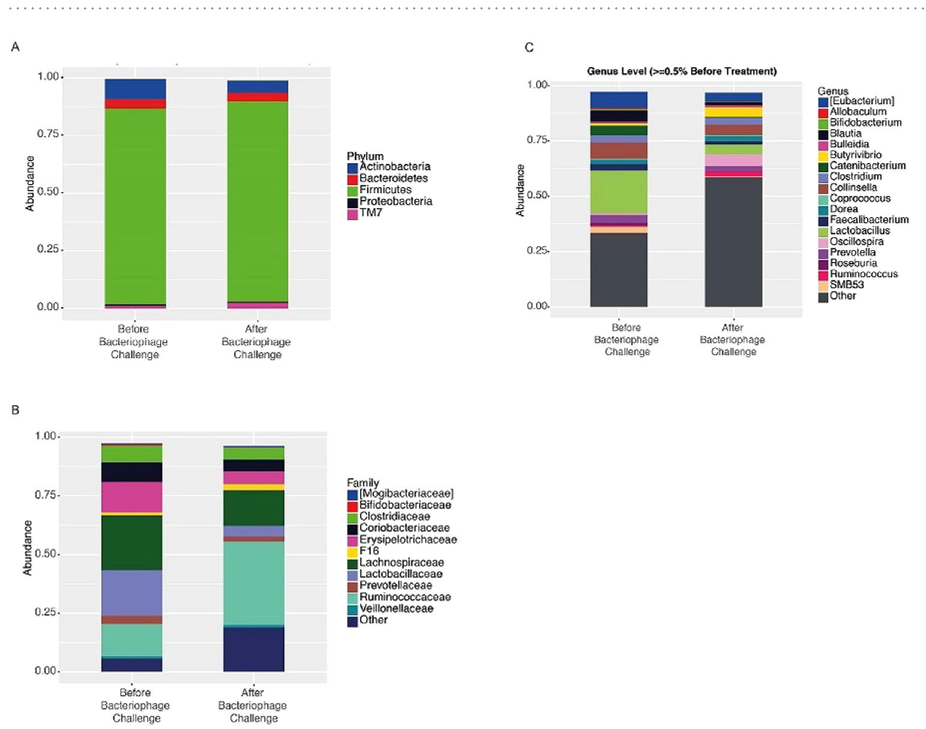
Figure 3. Comparison of relative abundance of predominant genera. Faecal bacterial communities were analysed by high-throughput sequencing of the 16S rRNA gene. Relative abundances of bacterial ( A ) phyla, ( B ) families, and ( C ) genera before and after the bacteriophage challenge at a level of ≥ 0.5% relative abundance. The term ‘other’ refers to the genera with the minimum abundance of <